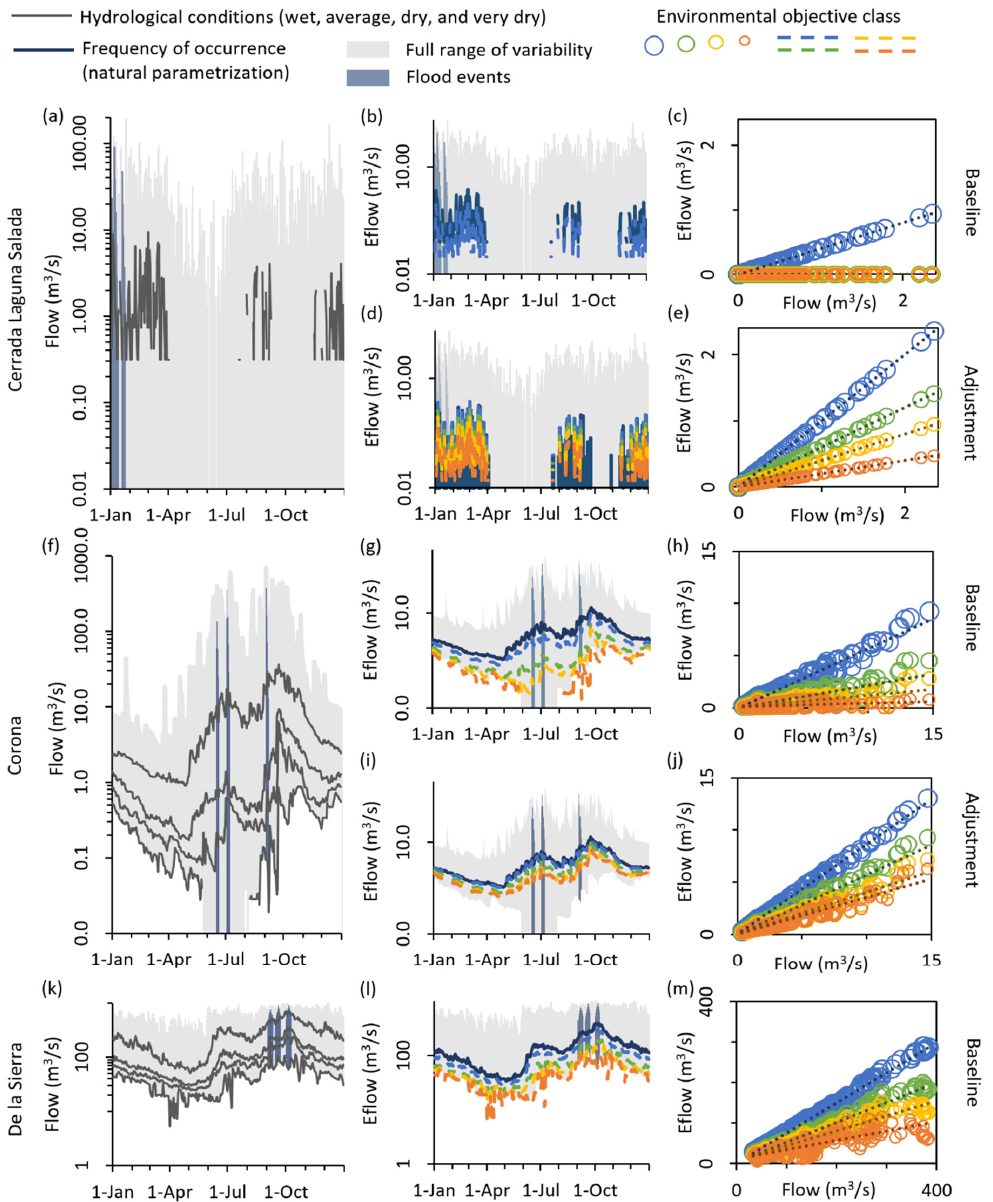
Figure 3. Performance assessment of the new frequency factors of occurrence for environmental flow allocation at three illustrative river sites, Cerrada Laguna Salada ephemeral stream, Corona intermittent river, and De la Sierra perennial river. First, wet, average, dry, and very dry conditions were computed at a daily scale for each calendar hydrological year based on each river site’s complete set of flow records (hydrographs on the left; ( a , f , k ) panels; flow rate displayed at a logarithmic scale). Second, integrated environmental flows were obtained based on the reference factors (values) for both the baseline and the adjustment (Table 1) according to the environmental objective classes (Equation (5)). The regime representative of the hydrological conditions was also calculated and plotted based on the corresponding values for natural parametrization, that is to say, 25%, 50%, 15%, and 10% (hydrographs in the middle; (( b , d , g , i , l ) panels). Third, the metrics for the performance assessment (r 2 and slope values) were calculated based on the correlation of the natural parametrization and the model outcomes per environmental objective (scatterplots on the right; (( c , e , h , j , m ) panels). This procedure was repeated for all the study sites and critically examined for each subset and the full set of outcomes according to the performance criteria previously